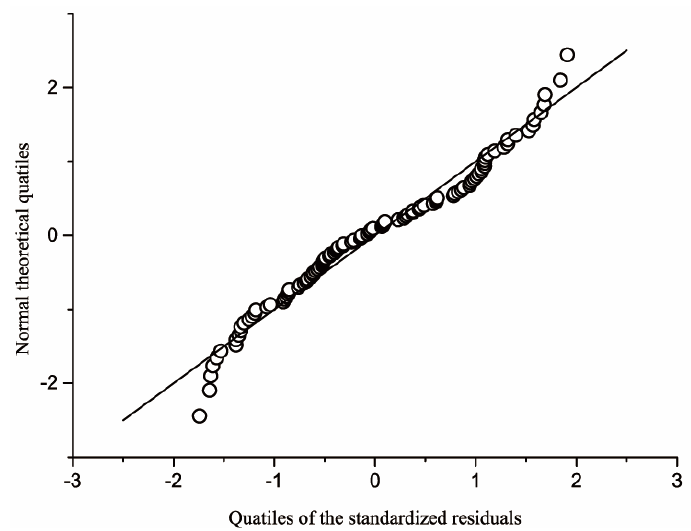
Figure 2. The normal quantile–quantile plot of the standardized residuals of the constructed sorghum–sudangrass hybrid yield prediction model.